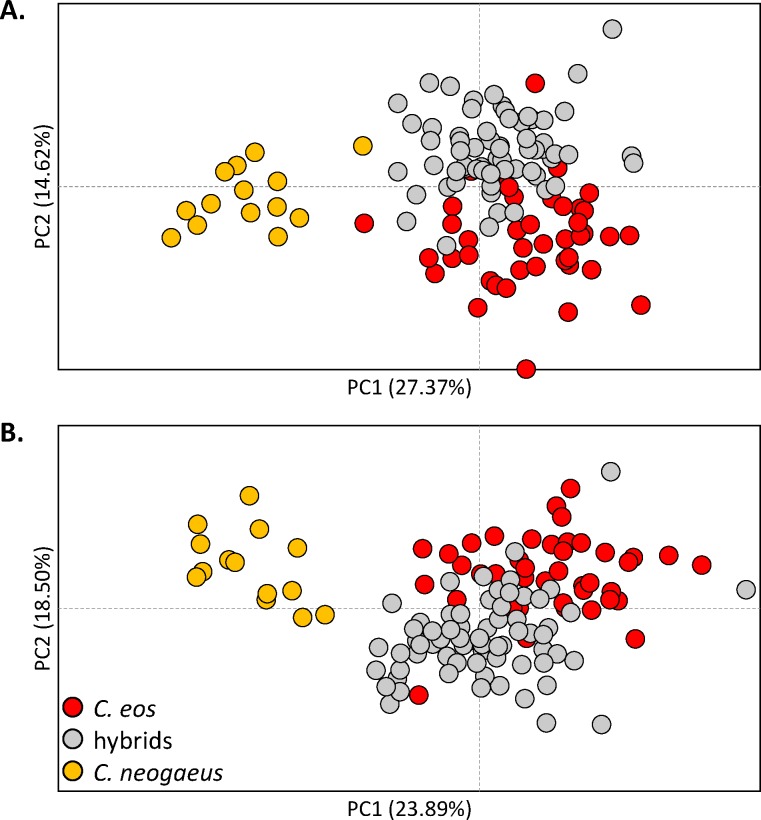
Disparity on shape of pharyngeal arches among the parental species and hybrids.Principal component analysis scatter plot for A. the left side and B. the right side for C. eos (red), hybrids (grey) and C. neogaeus (orange).